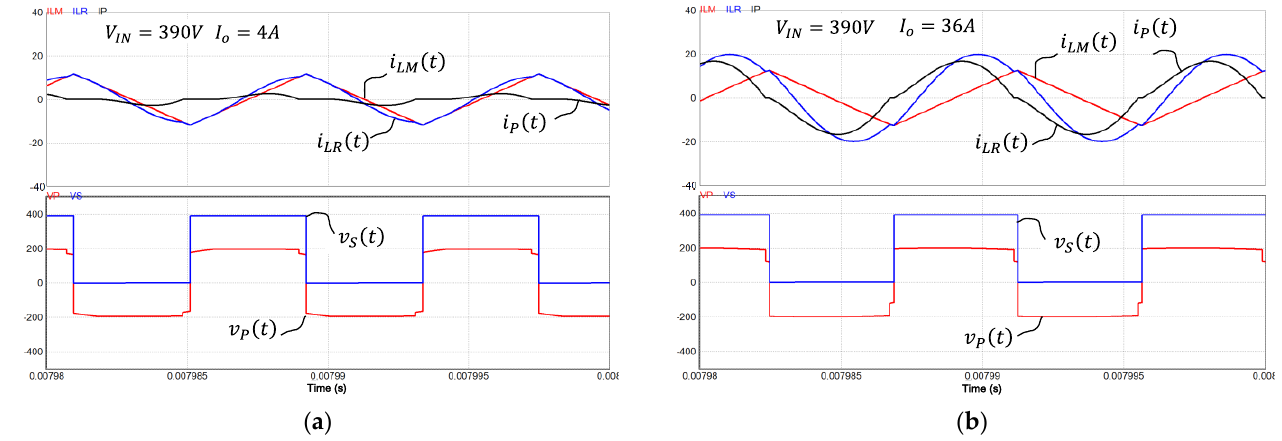
Figure 15. Steady-state waveform result of half-bridge LLC resonant converter with PSIM simulation: ( a ) At low load power; and ( b ) at full load power.